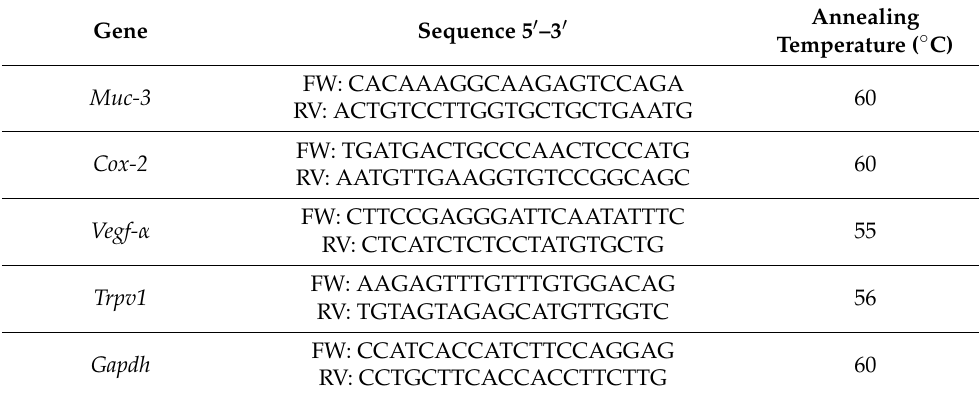
Table 1. Primer sequences employed for real-time PCR